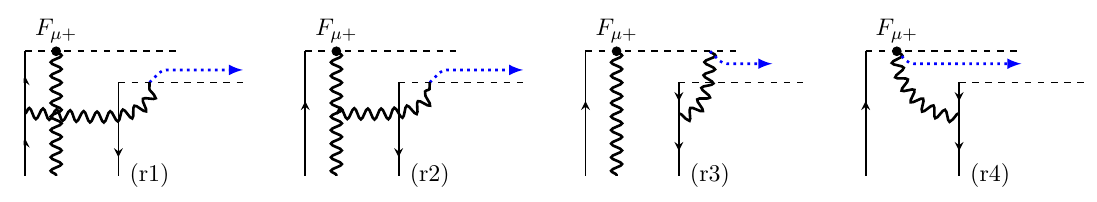
Figure 4 . The diagrams contributing to the rapidity divergence of TMD-twist-(1,2) operator. The blue arrow shows the rapidity divergent